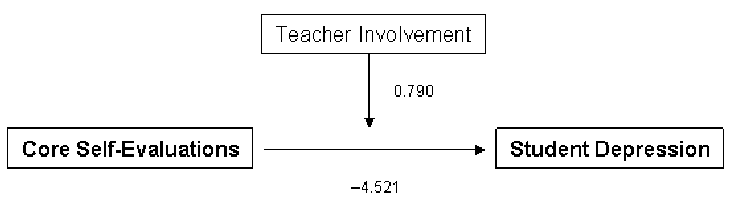
FIGURE 2 . Core self-evaluations to student depression: cross-level